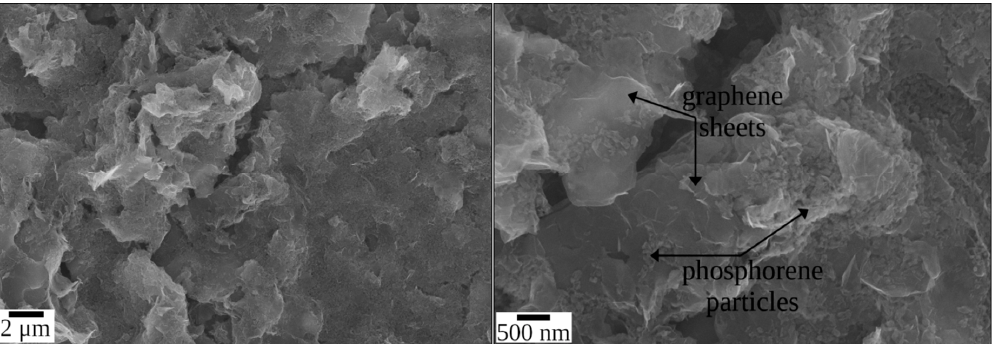
Figure 2. SEM images of the graphene-phosphorene composite at different magnifications.